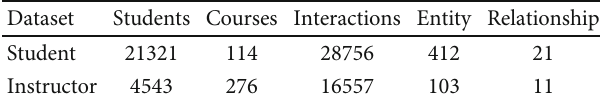
Table 1: Students ’ basic information